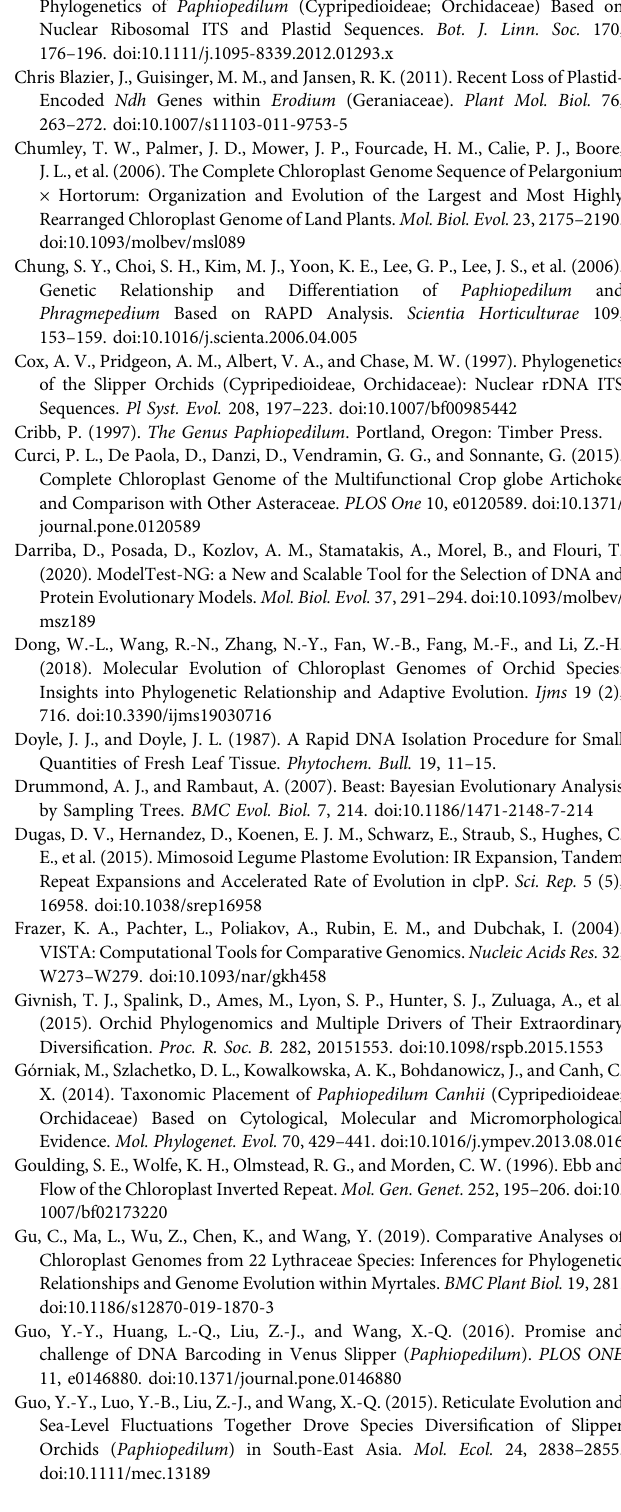
Frontiers in Genetics |